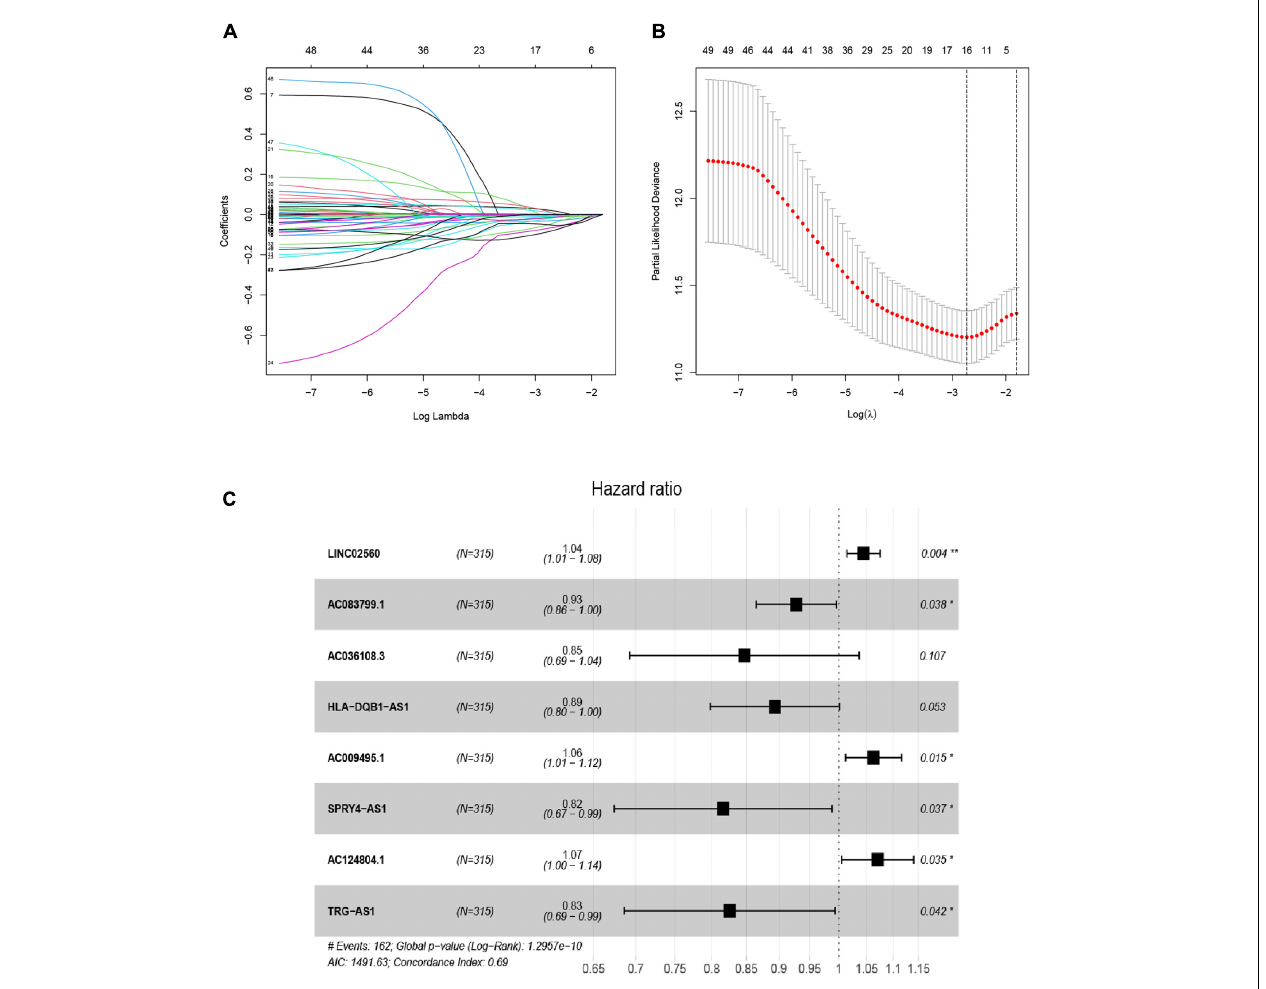
FIGURE 1 | Distinction of EMT-related lncRNAs correlated with melanoma prognosis: LASSO (A,B) , and multivariate Cox regression analysis (C) .